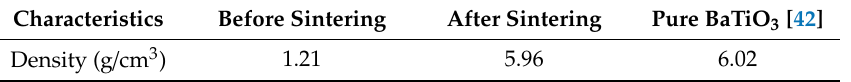
Table 1. The density of BiTO3 in different conditions.